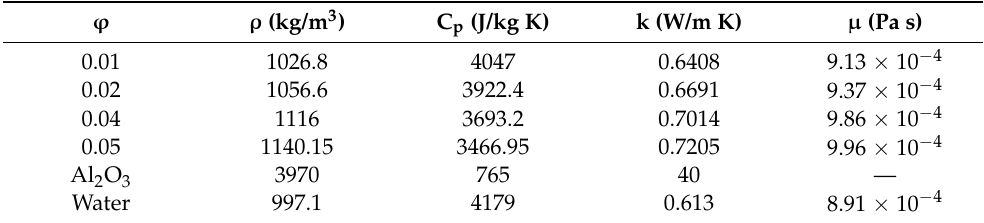
Table 4. Thermo-physical properties of Al 2 O 3 -water